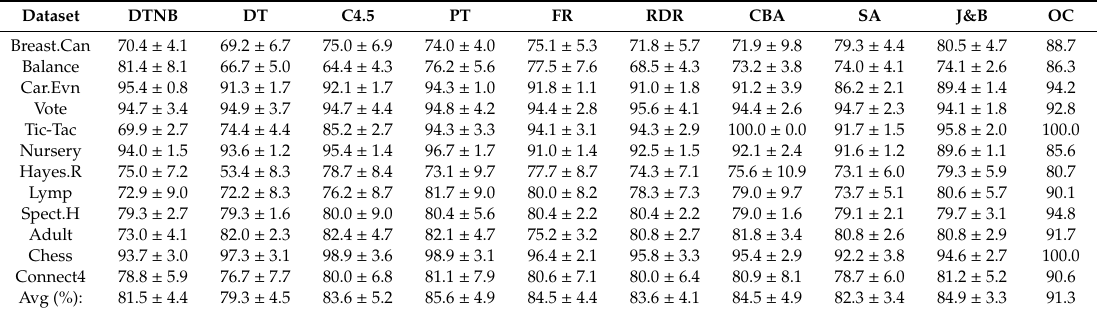
Table 6. The comparison between our method and some classification algorithms on accuracy. Dataset DTNB DT Breast.Can